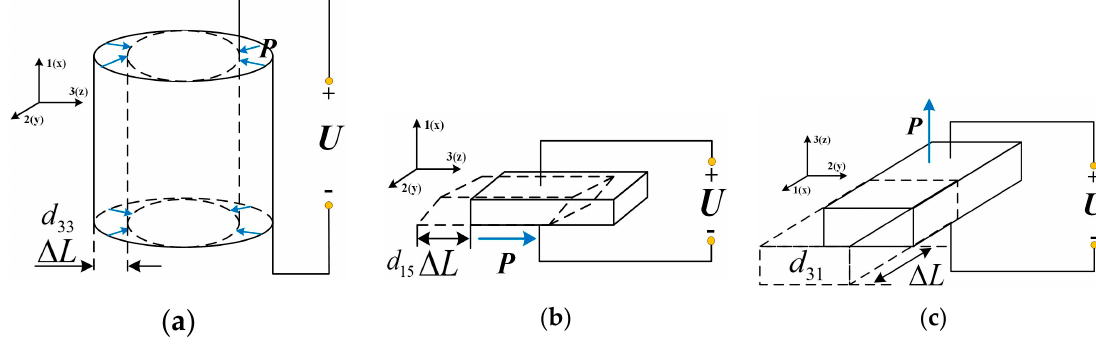
Figure 1. Strain modes of piezoelectric ceramics with three geometric structures: ( a ) d 33 mode in a hollow cylinder; ( b ) d 15 mode on a shear plane; ( c ) d 31 mode on a long plane.